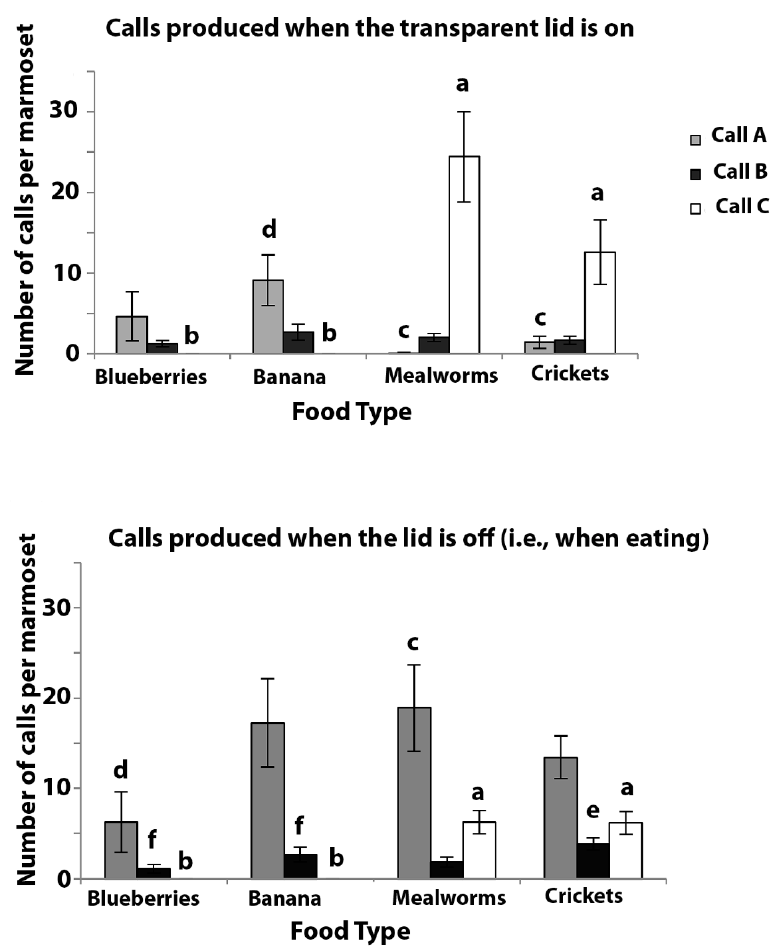
Figure 4. Experiment 3. These data are presented as in Figure 3 but here each marmoset was tested alone and N = 12. Bars marked with ( a ) differ significantly from those marked with ( b ), those marked ( c ) differ significantly from those marked ( d ) and similarly for those marked ( e ) versus ( f